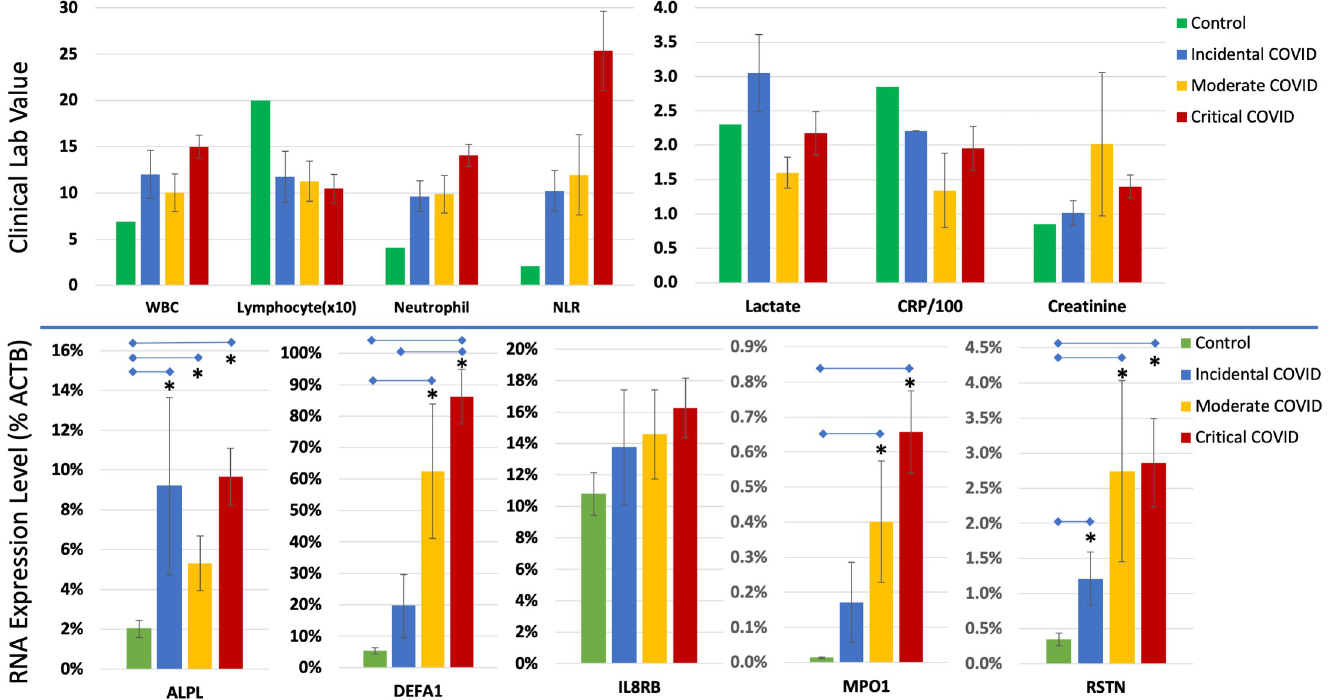
Fig 3. Clinical and RNA measures of COVID-19 severity. Upper panels : Patients testing positive for SARS-CoV2 by nasal swab PCR (n = 38) were divided into 3 groups of varying COVID-19 severity from Incidental (n = 7, asymptomatic and not the primary reason for admission), Moderate (n = 7, symptomatic but not on vasopressors or intubated), and Critical (n = 24, either vasopressors, intubated, or fatal). Reference levels (Control) are derived from published studies of normal controls. Bars reflect the white blood count (WBC), lymphocyte count (x10), neutrophil count, neutrophil/lymphocyte ratio (NLR), blood lactate, C-reactive protein (CRP), and creatinine for each group (mean ± s.e.m.). Lower panels : The same groups were used to calculate blood RNA levels for 5 transcripts, alkaline phosphatase (ALPL), defensin A1 (DEFA1), interleukin 8 receptor beta (IL8RB), myeloperoxidase 1 (MPO1), and resistin (RSTN), as a percentage of the actin B1 (ACTB) transcript used as the reference (i.e., ALPL in Incidental COVIDS is 9% of ACTB1 levels in copies per 20 μ l of RNA in blood by ddPCR). Control subjects are unaffected normal subjects (n = 7) tested by the same process. ( � = p < 0.05).